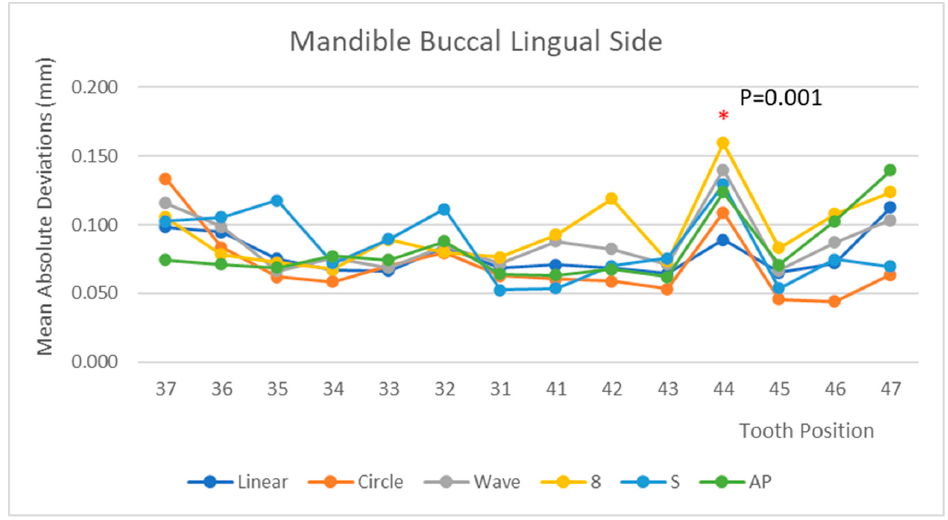
Figure 7. B-L deviations at different tooth positions among six head movements in the mandible. * Statistically different at tooth position among six movements.